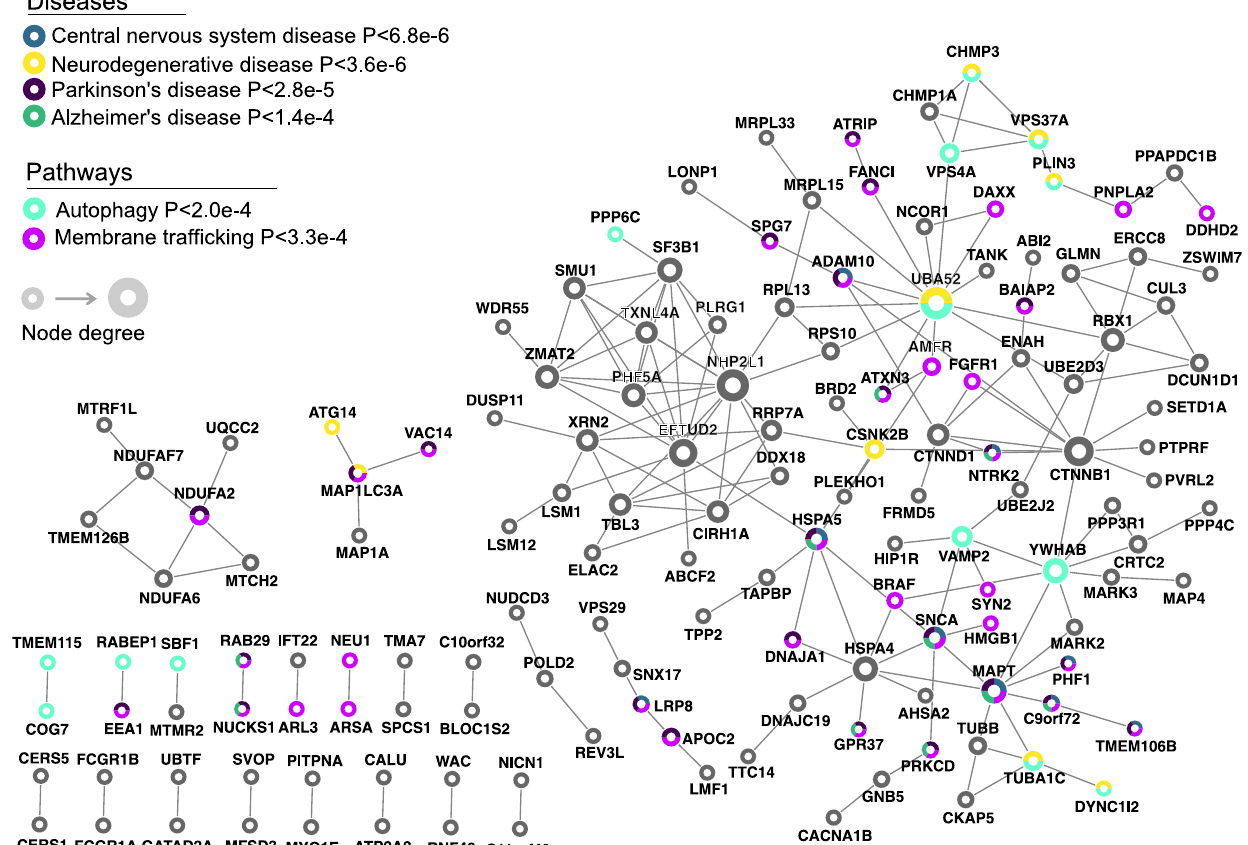
Fig. 6 | 3 ′ aTWAS prioritizes known and previously unknown susceptibility brain disorder genes that are connected in PPI networks and enriched in autophagy and membrane traf fi cking pathways. 3 ′ aTWAS genes are connected in PPI networks with known brain disorder genes. Pathway enrichment analysis